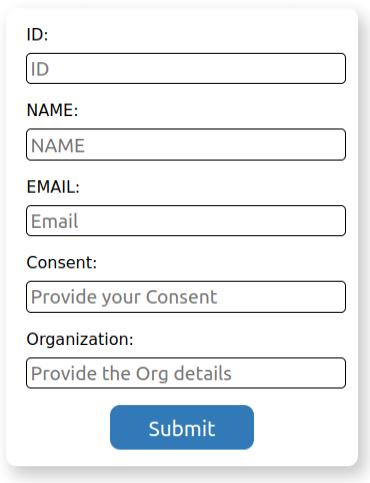
Figure 9. Adding consent details to the network.